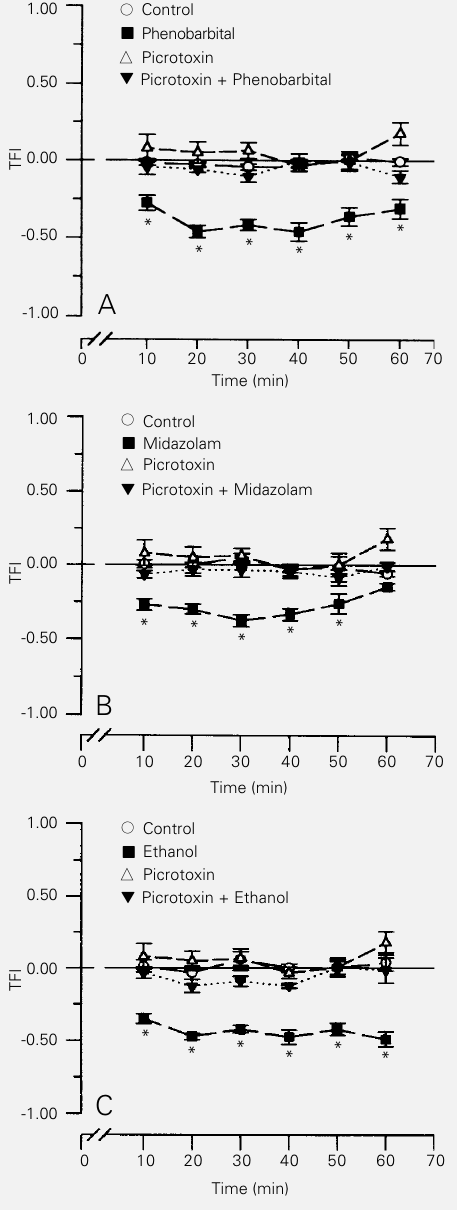
Figure 2 - Picrotoxin blocked the hyperalgesia induced by sys- temic phenobarbital (A), mida- zolam (B) or ethanol (C) adminis- tration to rats. Picrotoxin was ad- ministered ip 20 min before the tail-flick test. The agonists phe- nobarbital (20 mg/kg, ip ), mida- zolam (10 mg/kg, ip ) or ethanol (1.6 g/kg, oral) were adminis- tered 10 min before the test. Control animals were injected ip or orally treated with the respec- tive vehicles. Each point indi- cates the mean – SEM of the data from 8 rats. Hyperalgesia is indicated by the negative val- ues on the ordinate; positive values indicate antinociception. *P<0.05 compared to control (Duncan test). TFI, Tail-flick in-